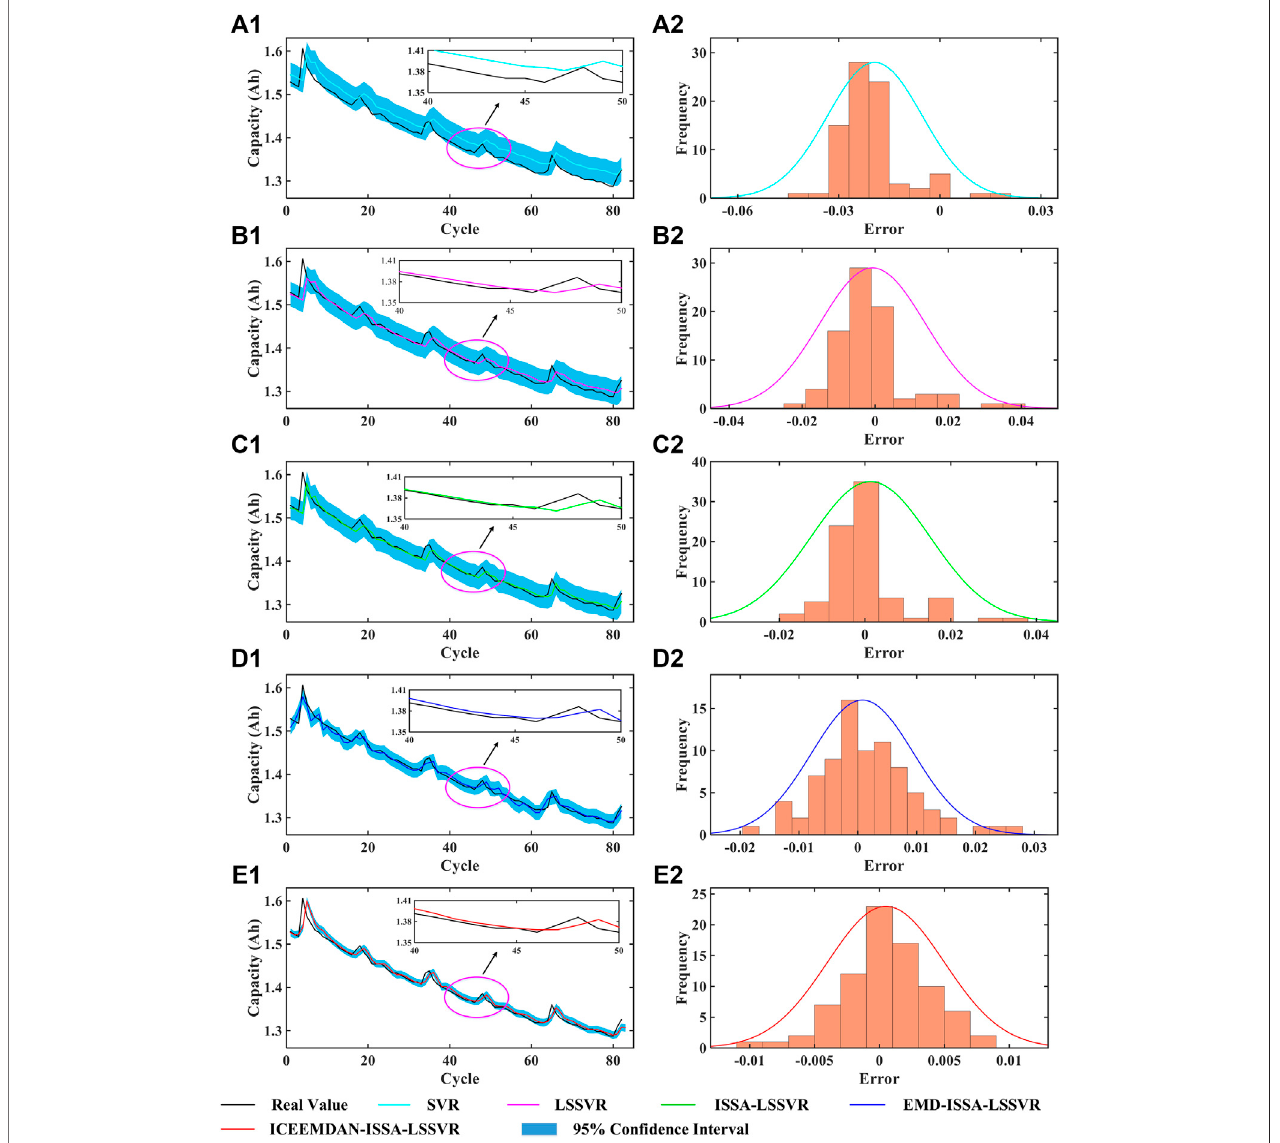
FIGURE 5 | Prediction results of the fi ve algorithms on the B0005 battery. (a1 – e1) Prediction capacity. (a2 – e2) Probability density curve of the prediction error.